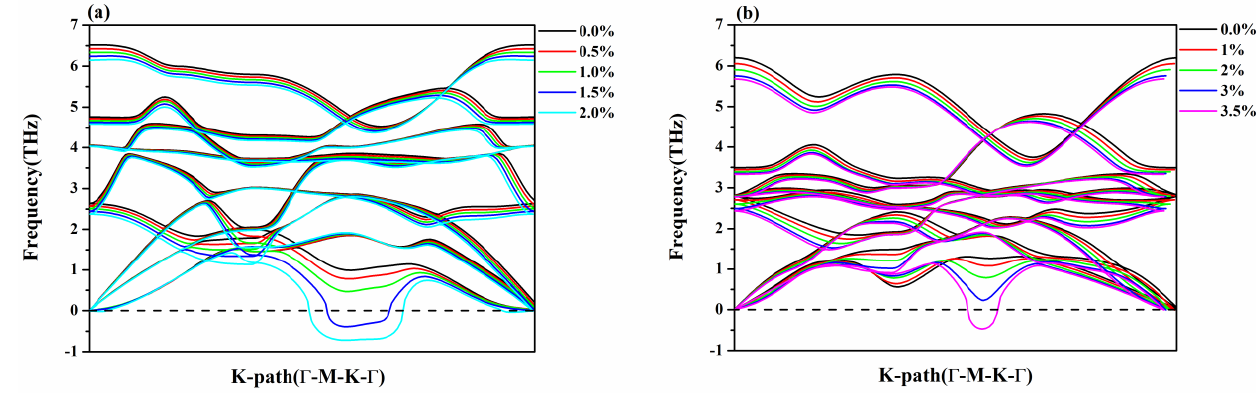
Figure 2. (Color online) Phonon dispersion curves under different tensile strains for ( a ) Se 2 Te and ( b ) SeTe 2 monolayers.